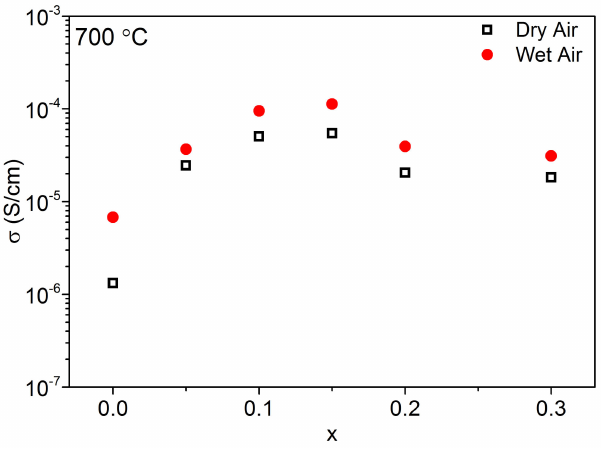
Figure 8. Total conductivities at 700 ◦ C of La 1 − x Tb x NbO 4+ δ .